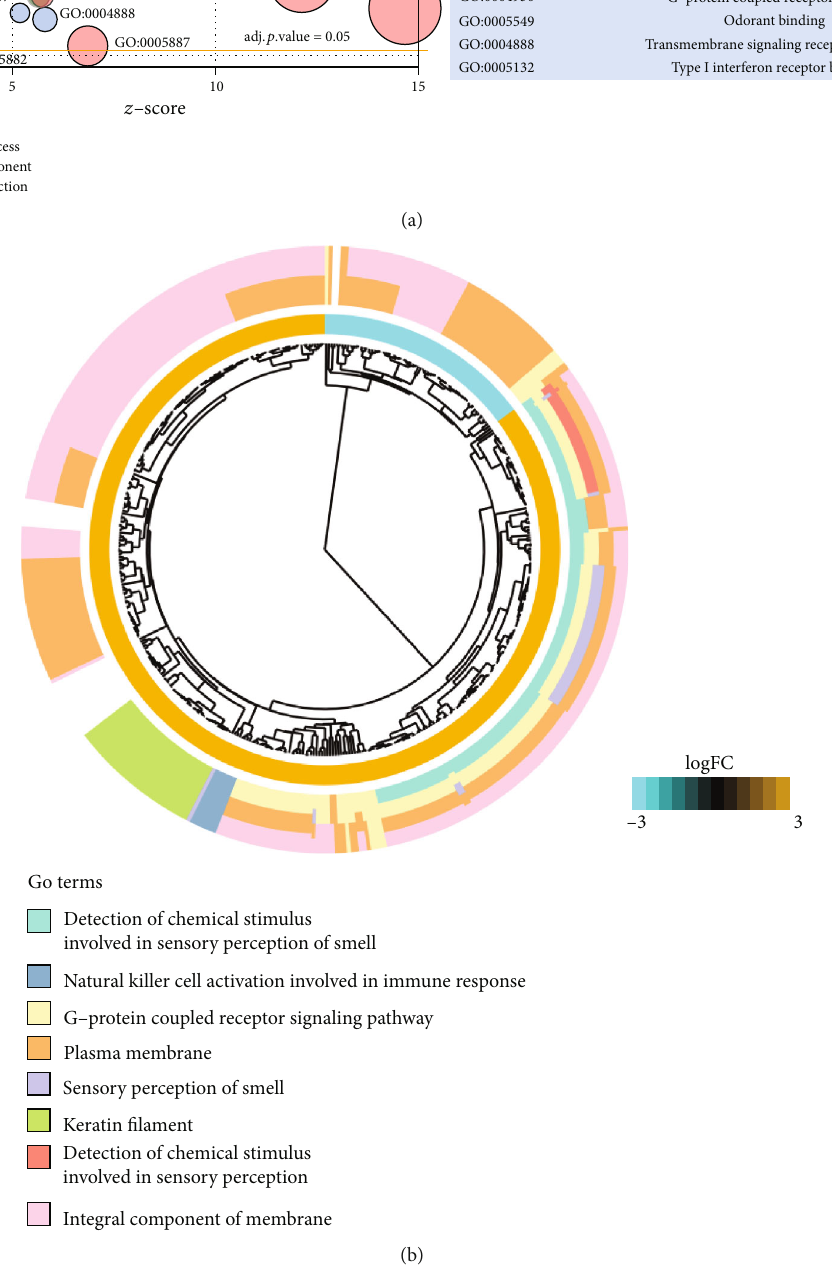
Figure 2: GO enrichment analysis results. (a) The top fi ve components for biological processes, cell components, and molecular functions were visualized. (b) Selection of top 8 GO terms and related di ff erential expressed genes for construction of highly clustering phylogenetic